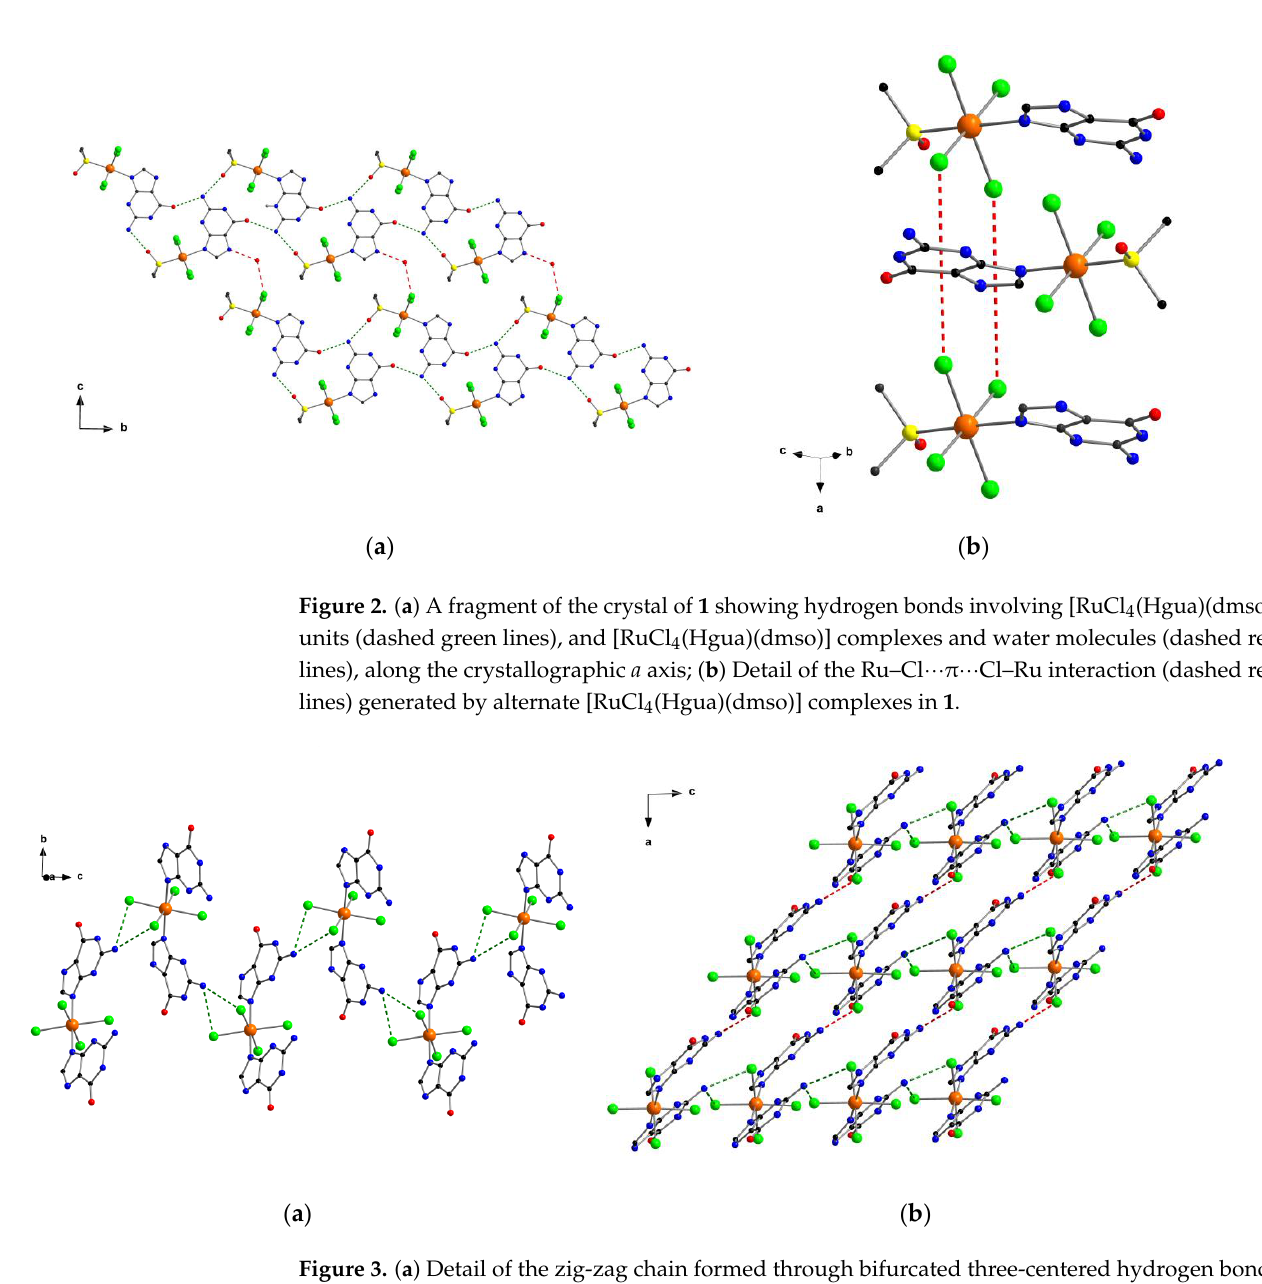
Figure 3. ( a ) Detail of the zig-zag chain formed through bifurcated three-centered hydrogen bonds (dashed green lines) between mononuclear [RuCl 4 (Hgua)(gua)] units in 2 ; ( b ) 2D arrangement of [RuCl 4 (Hgua)(gua)] complexes in 2 connected through additional hydrogen bonds (dashed red lines) and viewed along the crystallographic b axis.